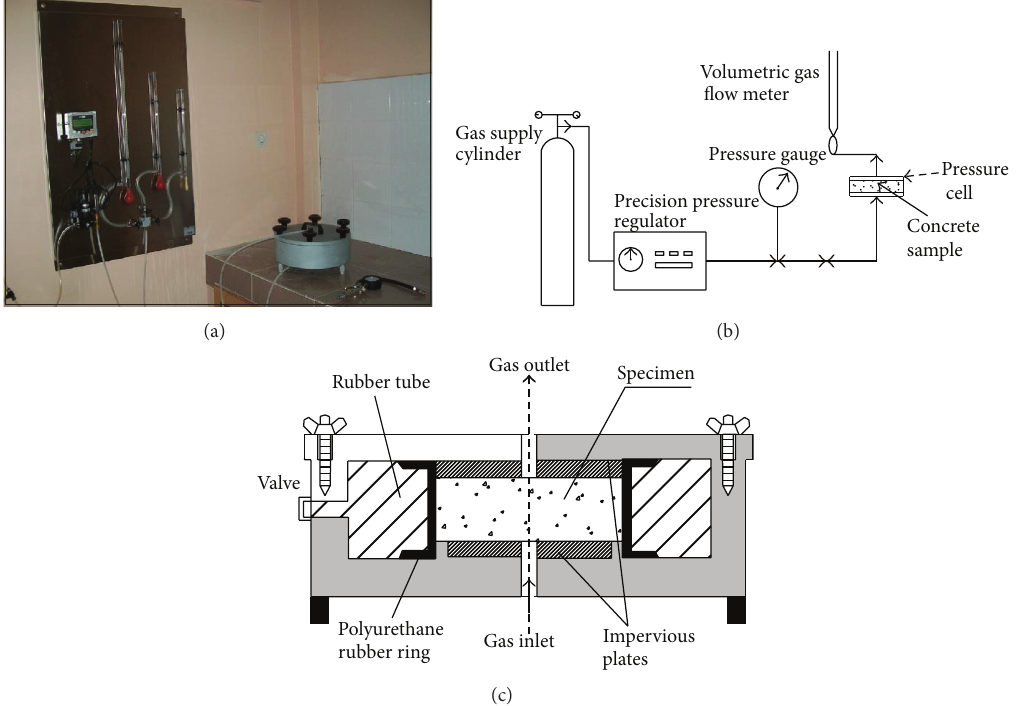
Figure 4: Gas permeability setup: (a) photographic view of the gas permeability test setup, (b) schematic presentation of the gas permeability test setup, and (c) schematic presentation of the pressure cell and test specimen.